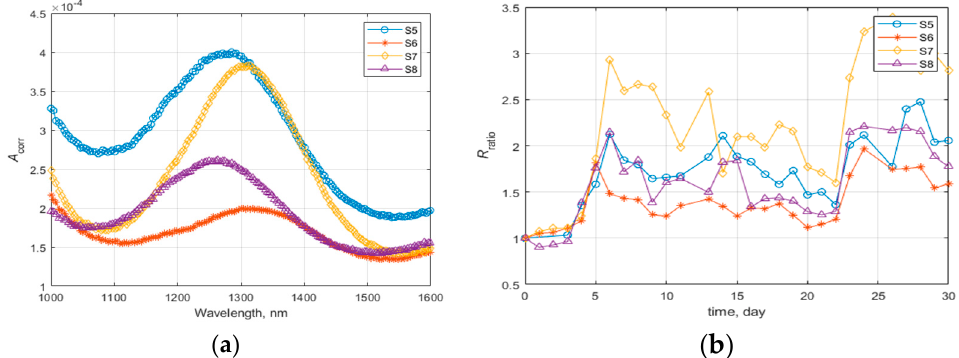
Figure 7. ( a ) Autocorrelation spectra (main diagonal of the 2D-COS synchronous spectrum) of sam- ples without the Ag electrode (S5, S6, S7 and S8), excited from the electrode side. ( b ) The R ratio vs. time.